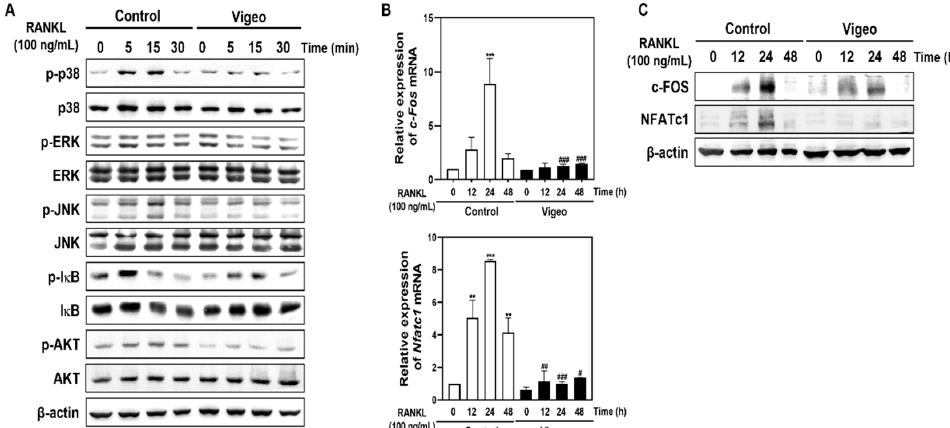
Figure 5. Vigeo affects receptor activator of nuclear factor-B ligand (RANKL)-induced phosphorylation of early signals and expression of c-FOS and NFATc1. ( A ) Bone marrow macrophages (BMMs)were seeded in the presence of M-CSF (10 ng/mL) for 1 day and then starved for 4 h. ( A ) Vigeo was used to pretreat the cells for 1 h followed by 0, 5, 15, and 30 min of RANKL stimulation. Whole-cell proteins were extracted by lysis using RIPA buffer and the protein expression was detected by western blotting using the indicated antibodies. ( B ) BMMs were cultured with M-CSF (30 ng/mL) and RANKL (100 ng/mL) in the presence or absence of Vigeo (100 µ g/mL). Total RNA was isolated from the cells and mRNA expression levels of c-Fos and Nfatc1 were evaluated by real-time RT-PCR. ** p < 0.01, *** p < 0.001 versus the control; # p < 0.05, ## p < 0.01, ### p < 0.001 versus the control at indicated times. ( C ) BMMs were cultured with M-CSF (30 ng/mL) and RANKL (100 ng/mL) in the presence or absence of Vigeo (100 µ g/mL). Protein expression was detected using western blotting with the indicated antibodies. β -actin was used as an internal control.